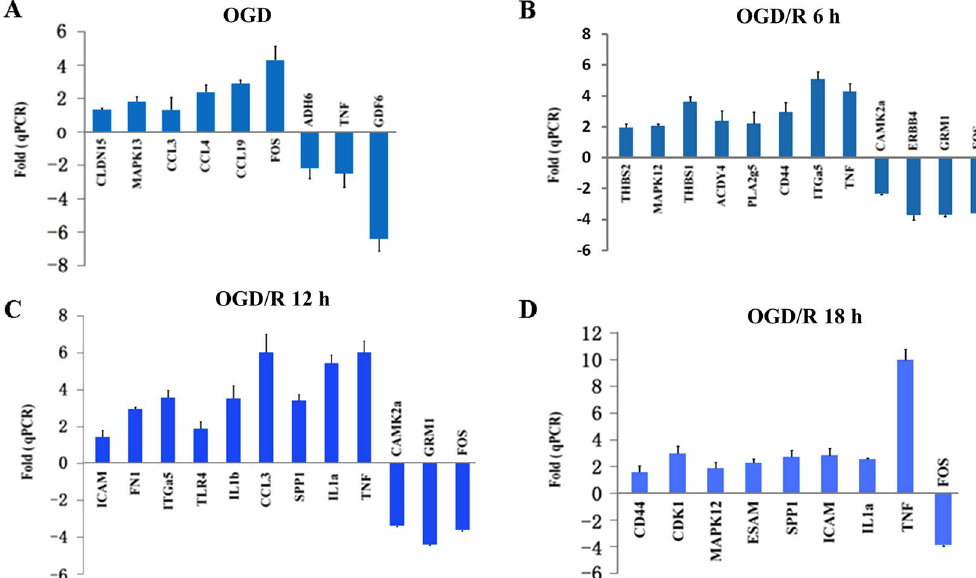
Figure 4. Validation of key regulatory genes involved in oxygen glucose deprivation (OGD) pathophysiology. (A–D ) The selected differentially expressed genes (DEGs) for OGD 45 min/R 0 h vs OGD 0 min/R 0 h ( A ); OGD 45 min/R 6 h vs OGD 45 min/R 0 h ( B ); OGD 45 min/R 12 h vs OGD 45 min/R 0 h ( C ); and OGD 45 min/R 18 h vs OGD 45 min/R 0 h ( D ) were validated by qPCR. For each time point, neurons were collected and pooled from hippocampal cells isolated from six embryos. Triplicates (from pooled RNAs) were then